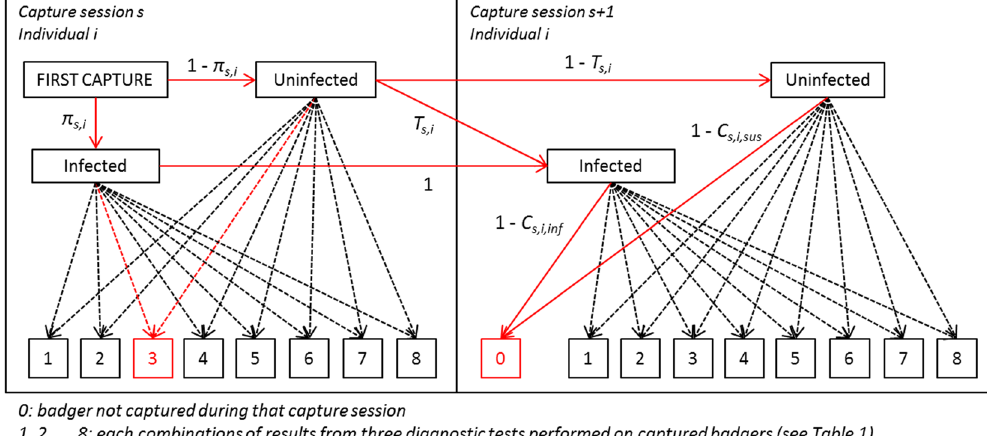
Figure 5. Multinomial tree diagram of the probability structure of the model at first and second capture. π s,i is the probability of being infected at first capture at capture session s (characterised by the external variables year and season) for individual i (characterised by the external variable sex). T s,i is the probability of transitioning from the uninfected to the infected state between capture sessions s and s + 1 for individual i. Finally, C s,i,inf and C s,i,sus are the capture probabilities at capture session s for individual I, for infected and uninfected badgers, respectively. Probabilities associated with the dashed arrows can be expressed as the product of the corresponding capture probability (C s,i,inf or C s,i,sus ) and the probability of observing the associated diagnostic test result combination given the epidemiological state (Supplementary Table S3). The red arrows highlight all pathways that could lead to the observation (3, 0): (the badger was infected at its first capture and the diagnostic test results showed combination 3 AND the badger was still infected at the following capture session when it was not captured) OR (the badger was not infected at its first capture and the diagnostic test results showed combination 3 AND (the badger was still not infected at the following capture session when it was not captured OR the badger was infected at the following capture session when it was not